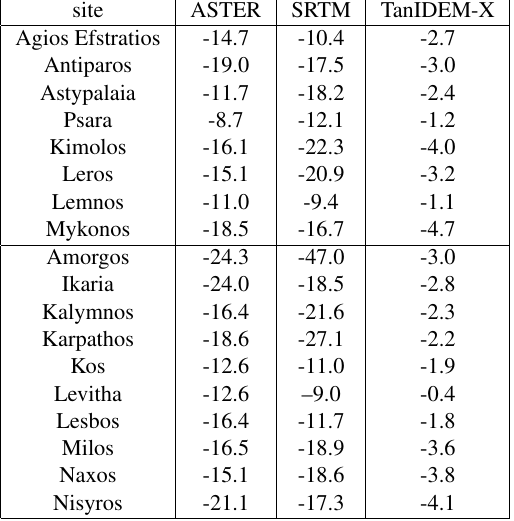
Table 7. Systematic translation (DZ) of the global DEMs with respect to local elevation data.